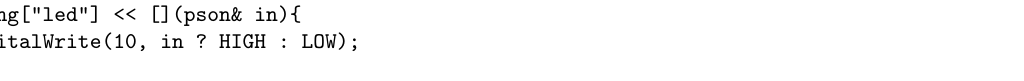
Figure 9. Turn on/off the digital pin 10.